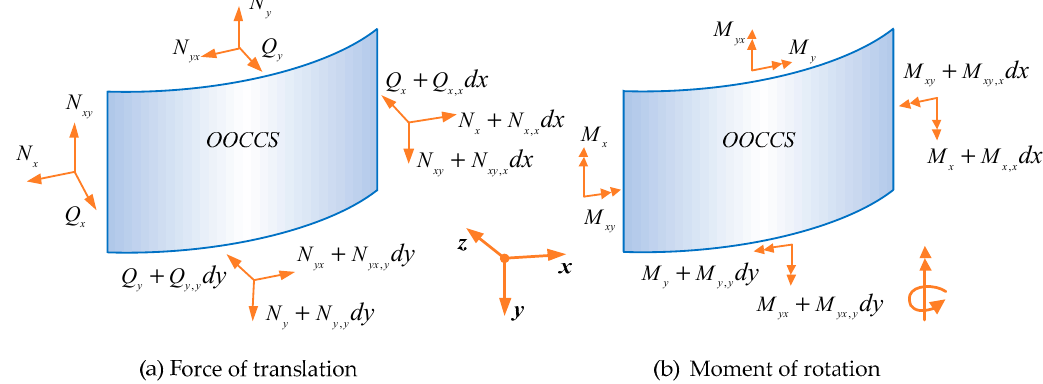
Figure 2. Force distribution diagram of an orthotropic open cylindrical shell element. OOCCS: orthotropic open circular cylindrical shell.